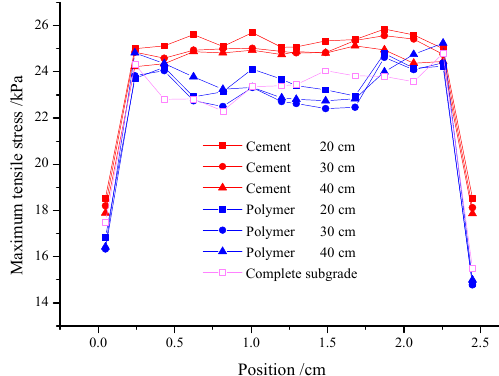
Figure 11. Variation of stress at the bottom of self-compacting layer with different thickness of lifted layer.